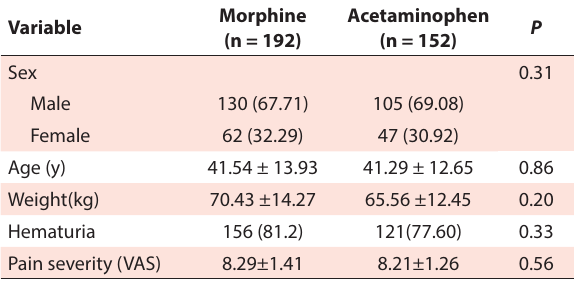
Figure 1. Figure 1. The study flowchart. The study flowchart Table1: Table 1. Comparison of baseline characteristics of the two groups Comparison of baseline characteristics of the two